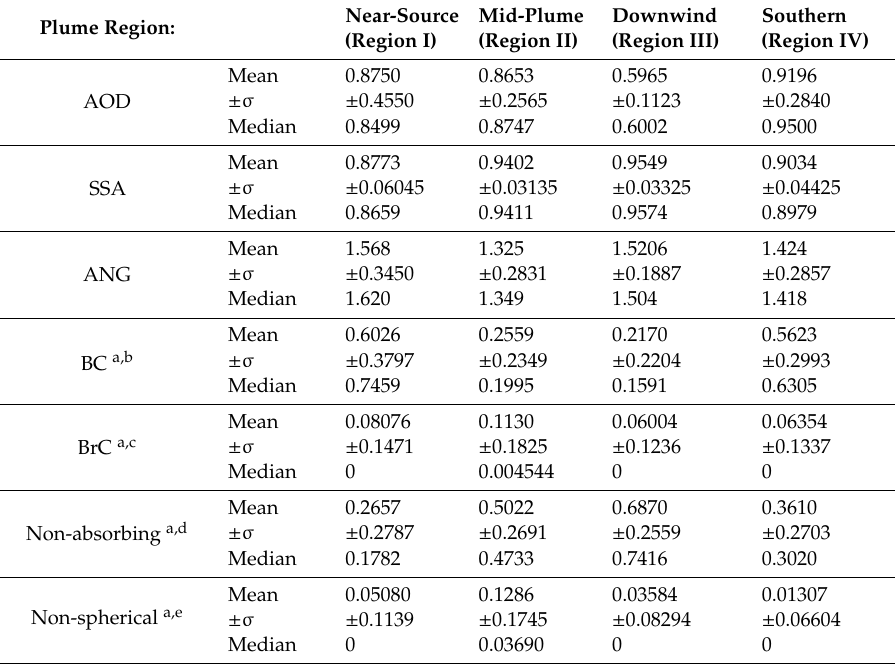
Figure 5. The absolute and fractional AOD (558 nm) of various MISR-RA aerosol size bins for the Williams Flats Fire on 06 August, 2019, where ( a , b ) are the sum of all “very small” components, ( c , d ) are the sum of all “small” components, ( e , f ) are the sum of all “medium” components, and ( g , h ) are the sum of all “large” components (which includes the non-spherical analog). Particles are assumed to be normally distributed around the effective radius (R e ) provided in the legend. Note that “large” aerosols ( g , h ), include both the large spherical nonabsorbing component (R e = 1.28) and the non-spherical component (R e = 1.21). Fractional plots are given as a fraction of 1. Note: scales differ between panels. Table 1. MISR-observed particle properties for the Williams Flats fire by region. AOD—aerosol optical depth; SSA—single scattering albedo (558 nm); ANG—extinction Ångström exponent (446–866 nm). Near-Source Plume Region: (Region